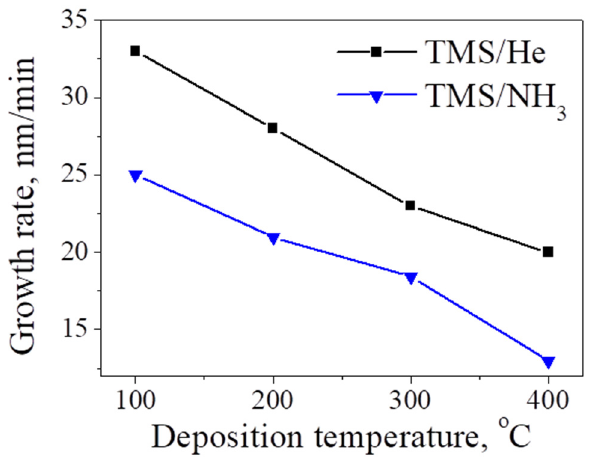
Figure 3. Deposition rate of SiC:H (SiCN:H) films deposited using TMS/He or TMS/NH 3 initial gas mixture as a function of deposition temperature.